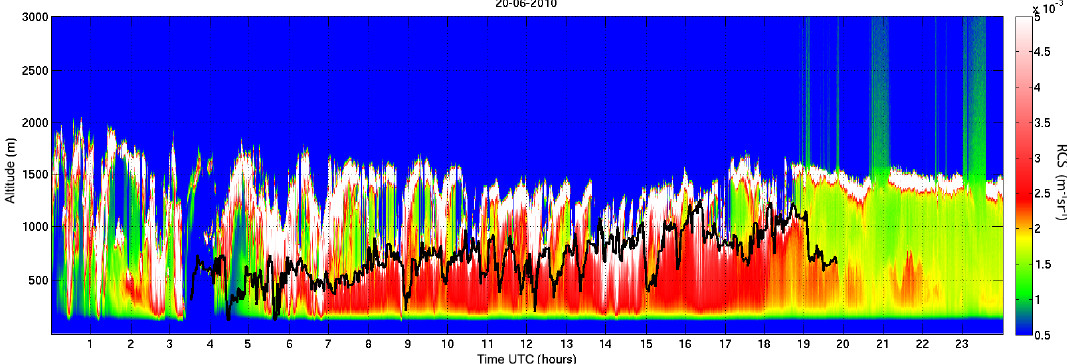
Figure 8. Lidar RCS together with pathfinder MLH estimate on 20 June 2010. A day with a completely overcast sky and precipitation falling from the cloud but (almost) completely evaporating before reaching the